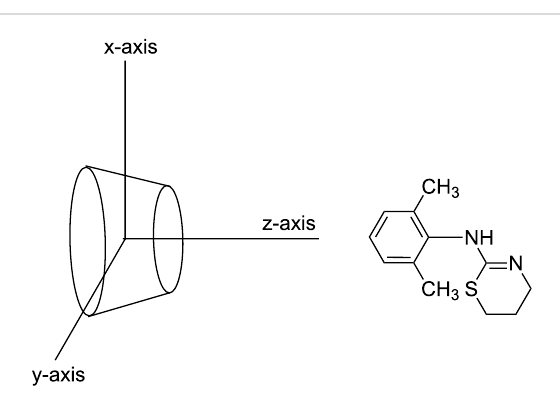
Figure 6: Coordinate system used to define the complexation process. every 10 iterations with 4000 steps of equilibration. Molecular dynamics simulation results provided evidence that complexa- tion of β -CD and xylazine is energetically favored. In both the cases, the total potential energy of the complex was less